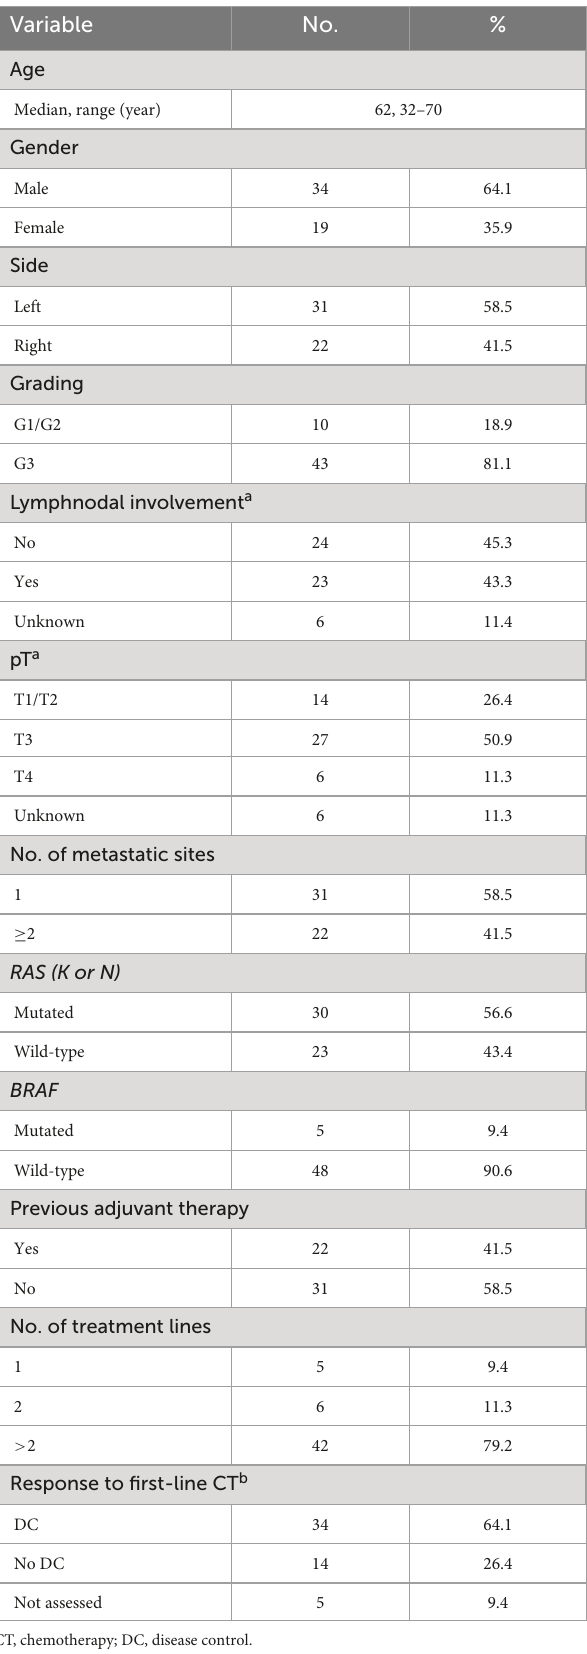
TABLE 5 Clinico-pathological characteristics of p53 assessed patients. Variable No.